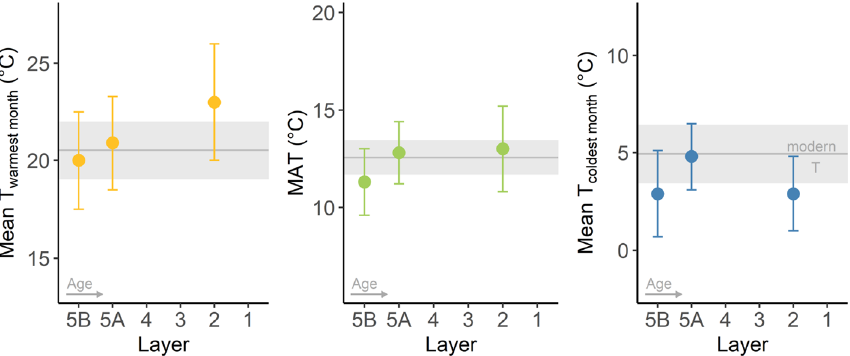
Figure 2. Reconstructed mean temperatures for the warmest month (left, yellow), mean annual temperature (middle, green) and mean temperatures of the coldest month (right, blue) and of the year by layer compared to modern day conditions in Gourdon (mean—grey line, standard deviation—grey ribbon, 1996–2017 average 31 ). Error bars indicate compound error around the temperature